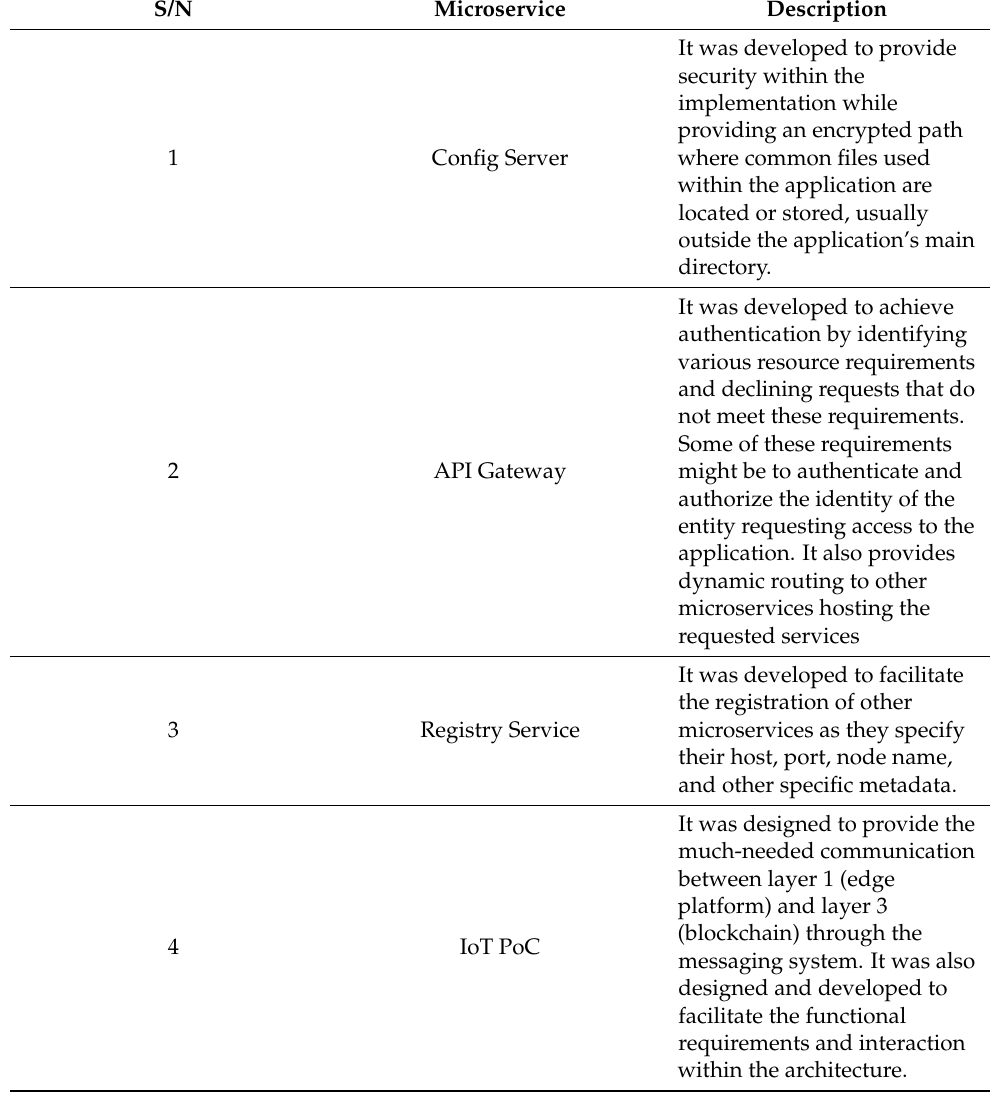
Table 3. Selected EdgeX microservices description and their respective port